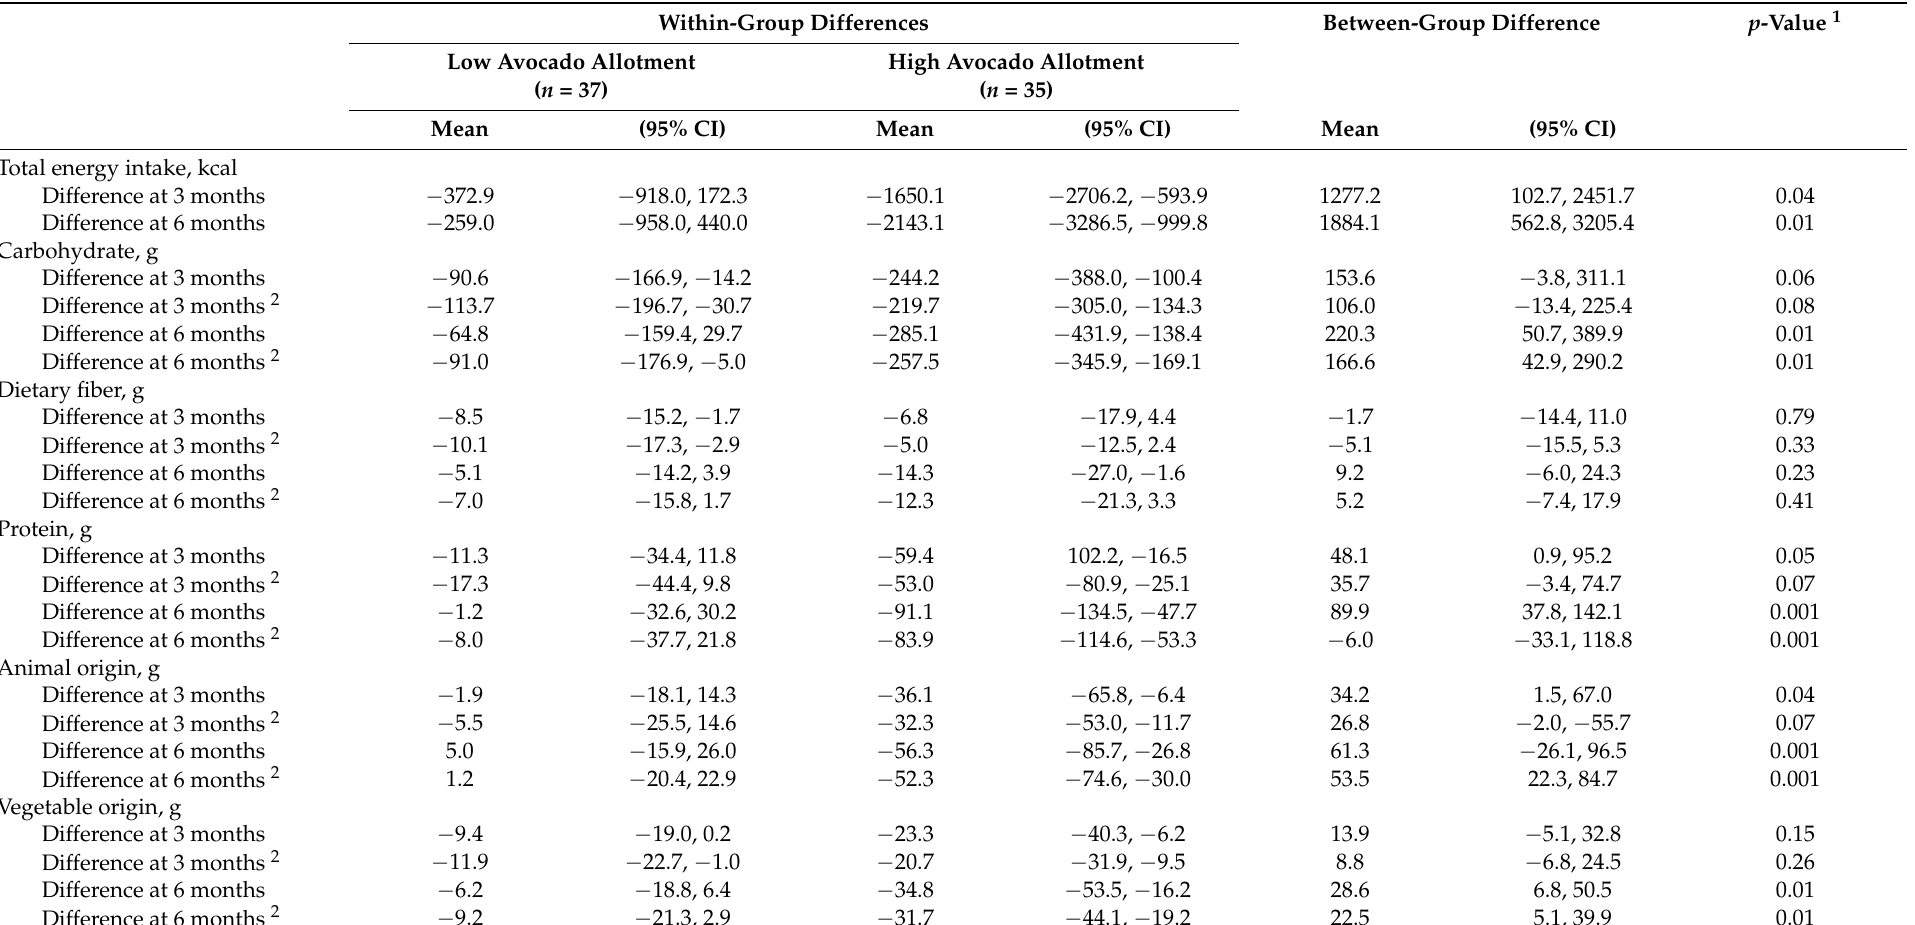
Table 3. Changes in family nutritional status per intention-to-treat analysis in the Effects of Avocado Intake on the Nutritional Status of Families Trial ( n =